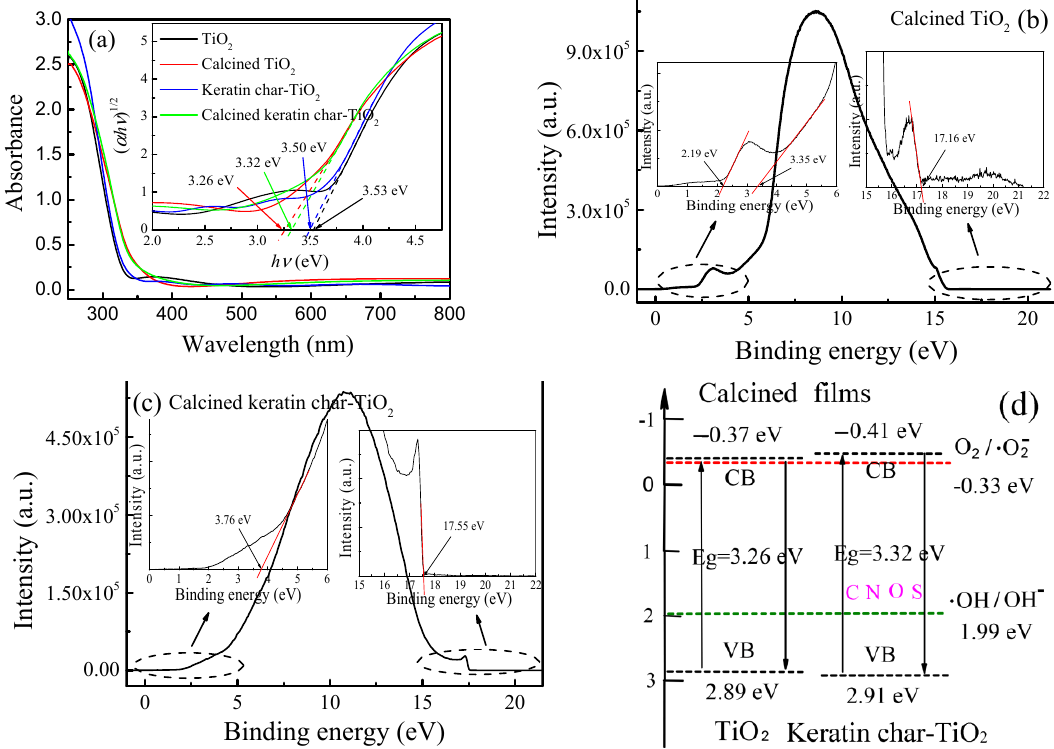
Figure 7. The ( a ) transmission spectra inserted with the plots of ( α h ν ) 1/2 versus h ν of the TiO 2 films and keratin char-TiO 2 composite films before and after calcination, the ( b , c ) UPS spectra and ( d ) corresponding schematic of electron band gap structures of the calcined films.